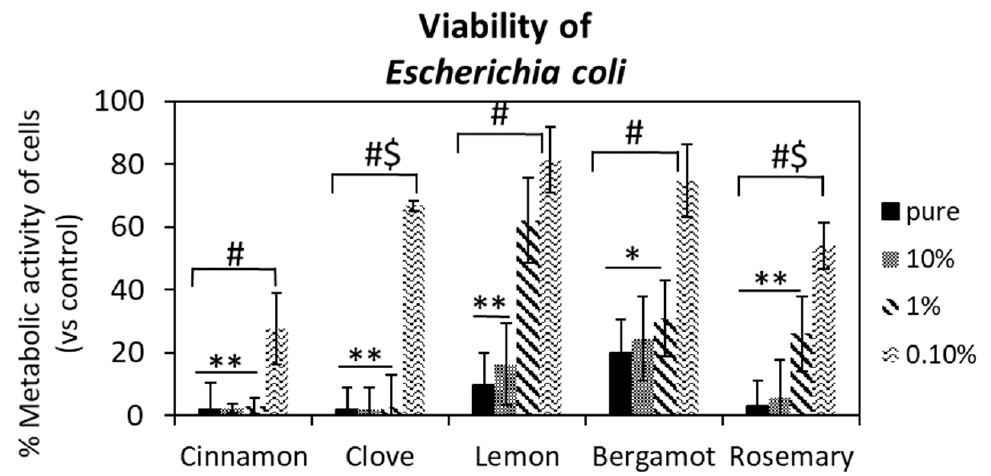
Figure 3. Metabolic activity of E. coli in the presence of EOs. The results were normalized with LB supplemented with 10% DMSO in PBS solution as a control sample. 10%, 1% and 0.1% indicate concentrations of EOs ( v / v ). * and ** indicate p -value < 0.05 and <0.01 between EO concentrations and control samples, respectively, while # and #$ show p -value < 0.05 and <0.01 between different concentrations of EOs, respectively.